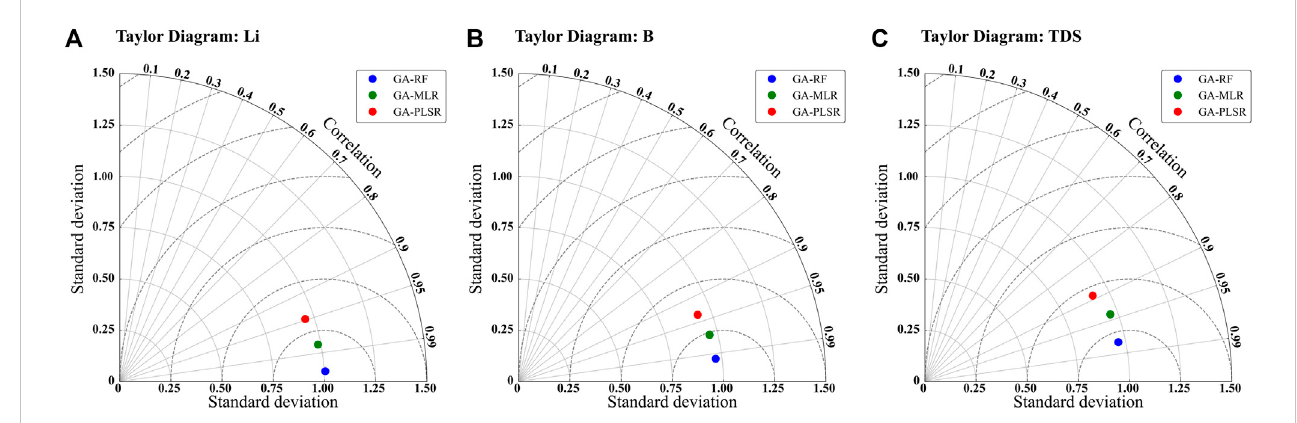
FIGURE 13 Taylor diagram of the GA-RF, GA-MLR, and GA-PLSR models. (A) Li; (B) B; (C) TDS.